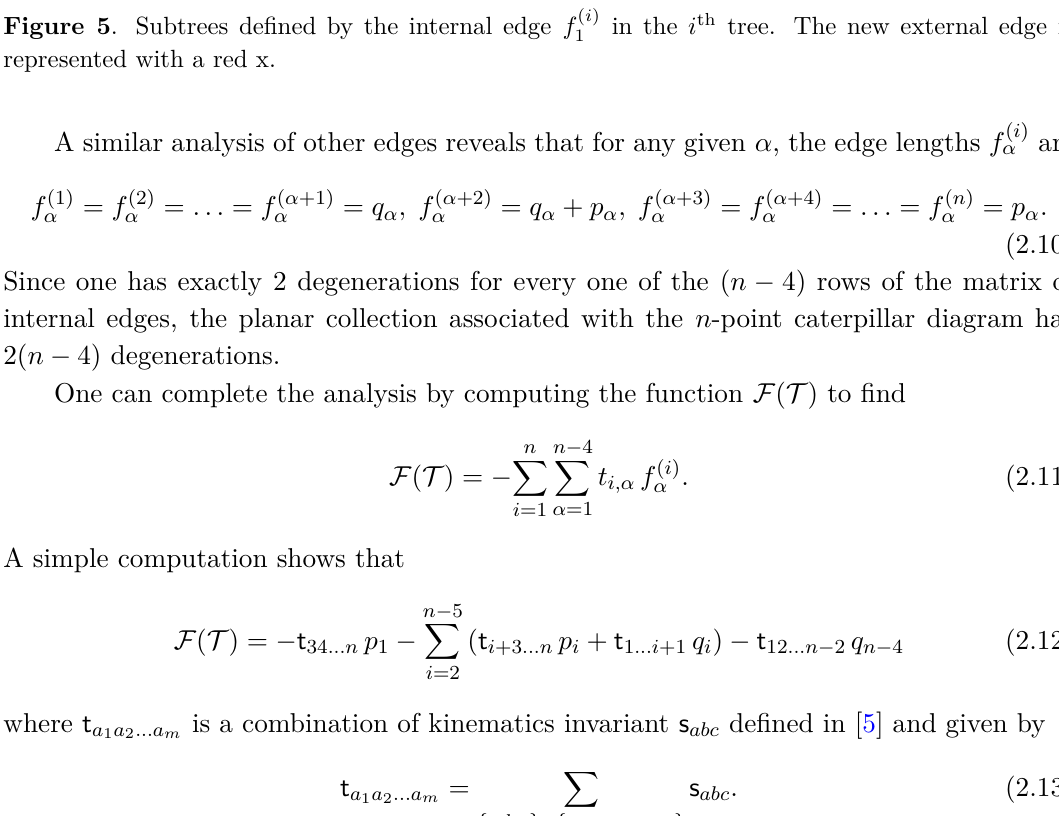
in the i th tree. The new external edge is 1